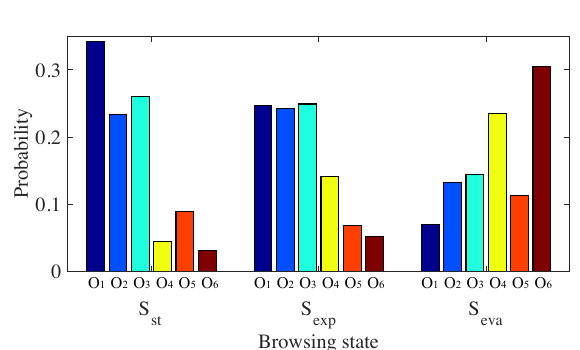
Figure 14 . The output probabilities of each browsing state. The color of the bars corresponds to the color of gaze features in Fig. 13